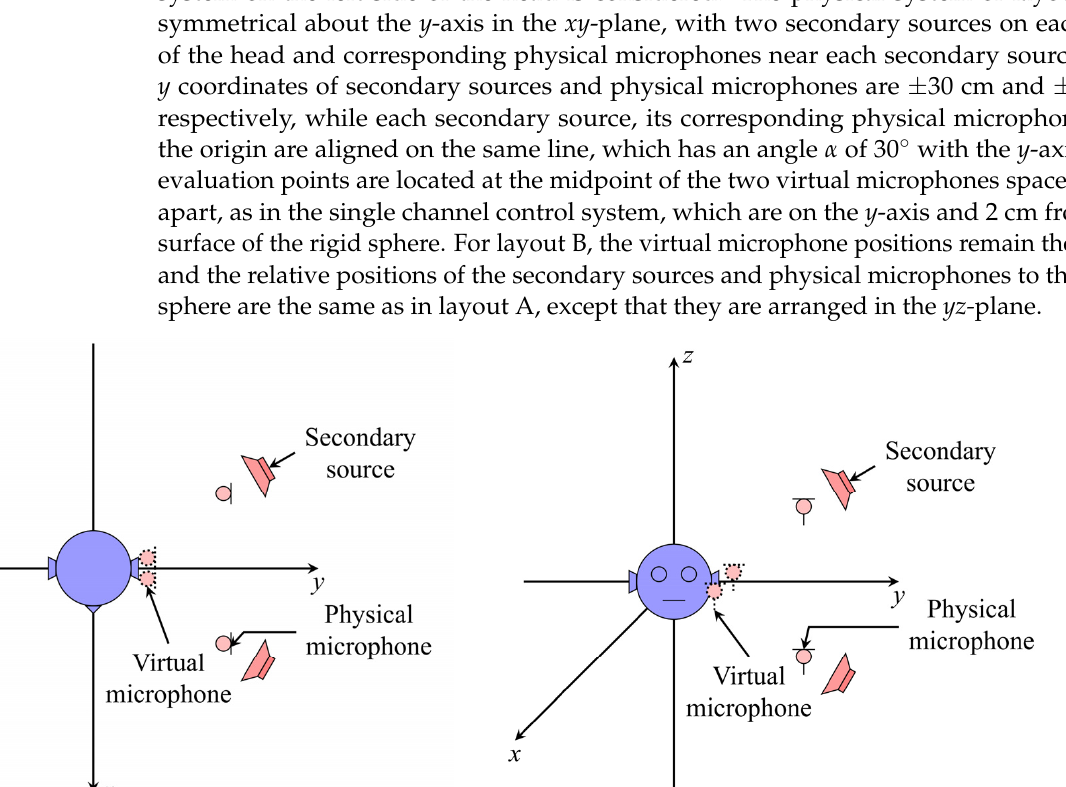
( b ) Figure 4. Dual-channel active headrest system: ( a ) layout A (top view); ( b ) layout B (front view).